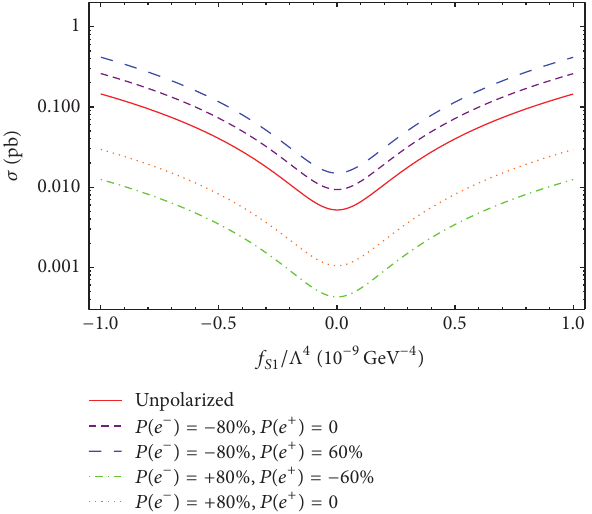
Figure 4: The total cross section for 𝑒 + 𝑒 − → ] 𝑒 𝑊 − 𝑊 + ] 𝑒 processes as a function of 𝑓 𝑆1 /Λ 4 at the √𝑠 = 1.4 TeV for different polarization of the positron and electron